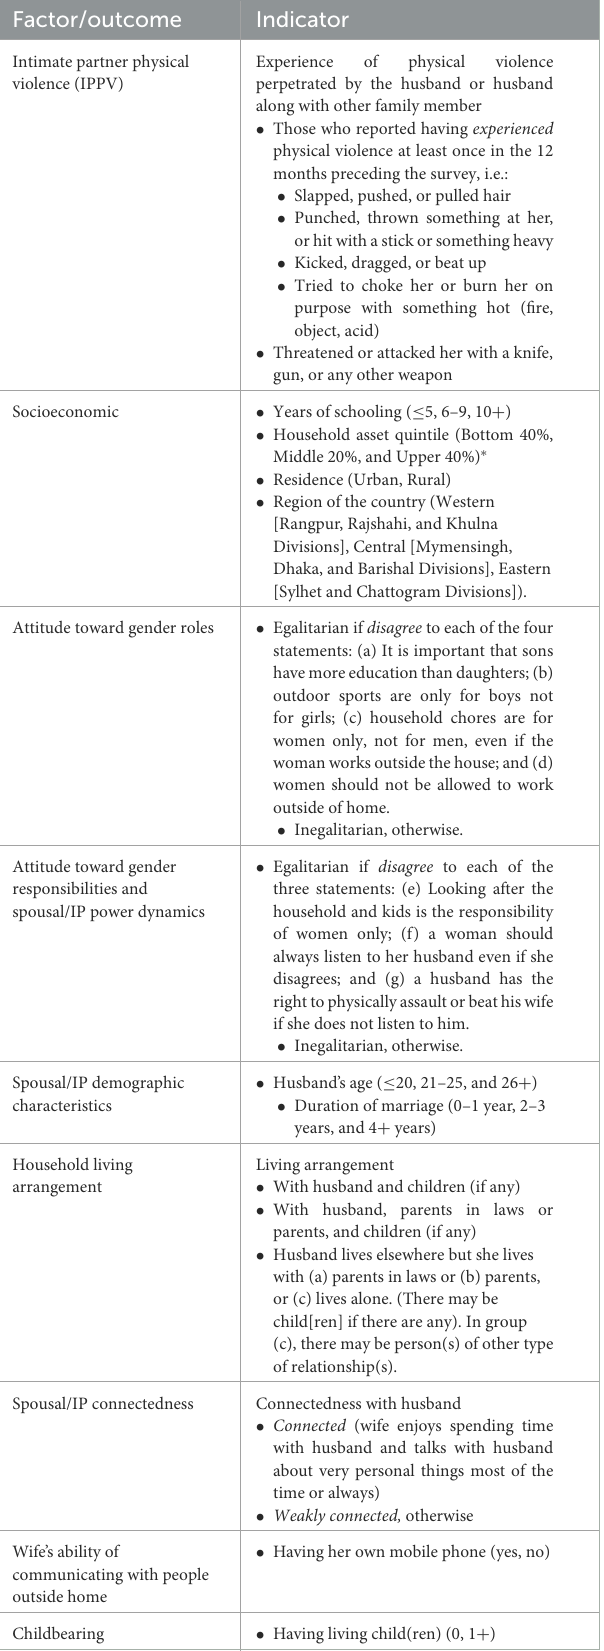
TABLE 1 Indicators and measurement of factors and outcome.